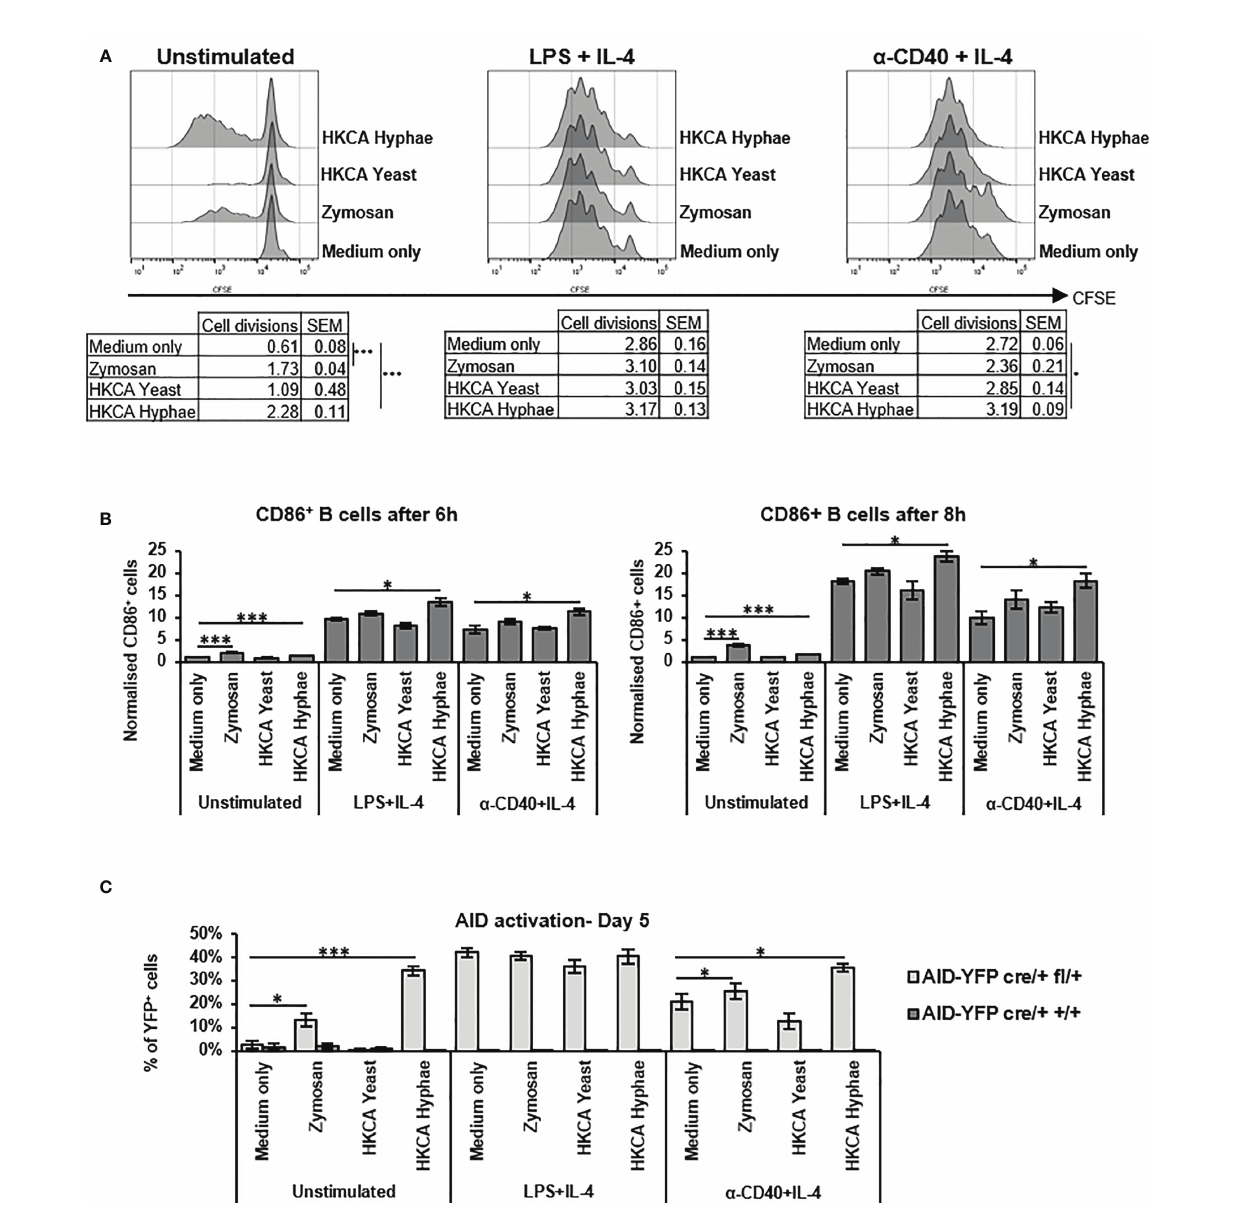
FIGURE 2 | Zymosan and HKCA hyphae lead to increased B cell activation. Splenic mouse B cells were cultured either unstimulated or stimulated with LPS+IL-4 or anti-CD40+IL-4 in the presence of Zymosan, HKCA yeast or HKCA hyphae. (A) B cell proliferation. Cells were stained with CFSE before culture and B cell proliferation was measured for 4 days by fl ow cytometry based on CFSE dilution. Representative plots from day 4 are shown. Tables show number of cell divisions in 4 days. (B) CD86 expression. CD86 expression was measured by fl ow cytometry 6 and 8 hours after stimulation. For combination of data from 3 experiments, the percentage of CD86+ cells in cells cultured unstimulated with medium only was set to 1. For representative plots and gating strategy, see Supplementary Figure S1D . (C) AID activation. The percentage of YFP-positive cells within live B cells was measured by fl ow cytometry after 5 days of culture. For representative plots and gating strategy, see Supplementary Figure S2B . Data represent mean ± SEM of 3 mice, with triplicate measurements performed for each mouse. *p < 0.05, ***p <